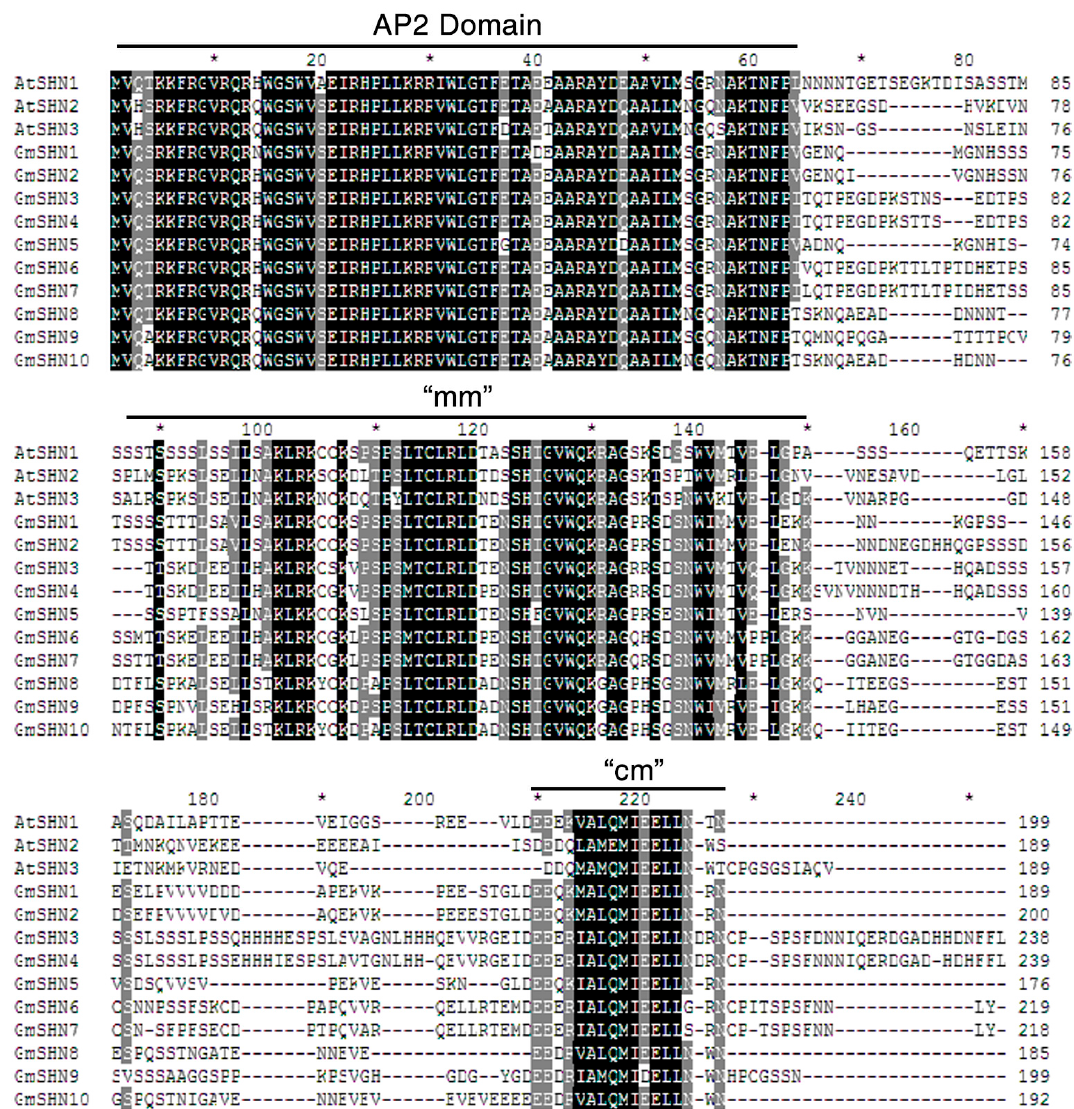
Figure 1. Multiple sequence alignment of the three Arabidopsis SHN proteins and ten putative homologs from soybean. Residues are highlighted in black for 100% identical, gray for at least 80% identical, respectively. mm, middle motif; cm, C-terminal motif; * , abbreviation of sequence numbers.